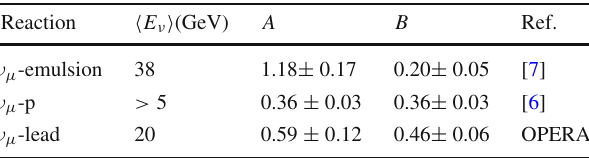
Fig. 9 The charged hadrons multiplicity dispersion as a function of (cid:3) n (cid:4) ch Table 5 Values of parameters A and B obtained by a linear fit on the distribution of D ch versus (cid:3) n ch (cid:4) . The results obtained in other neutrino experiments are also shown Reaction